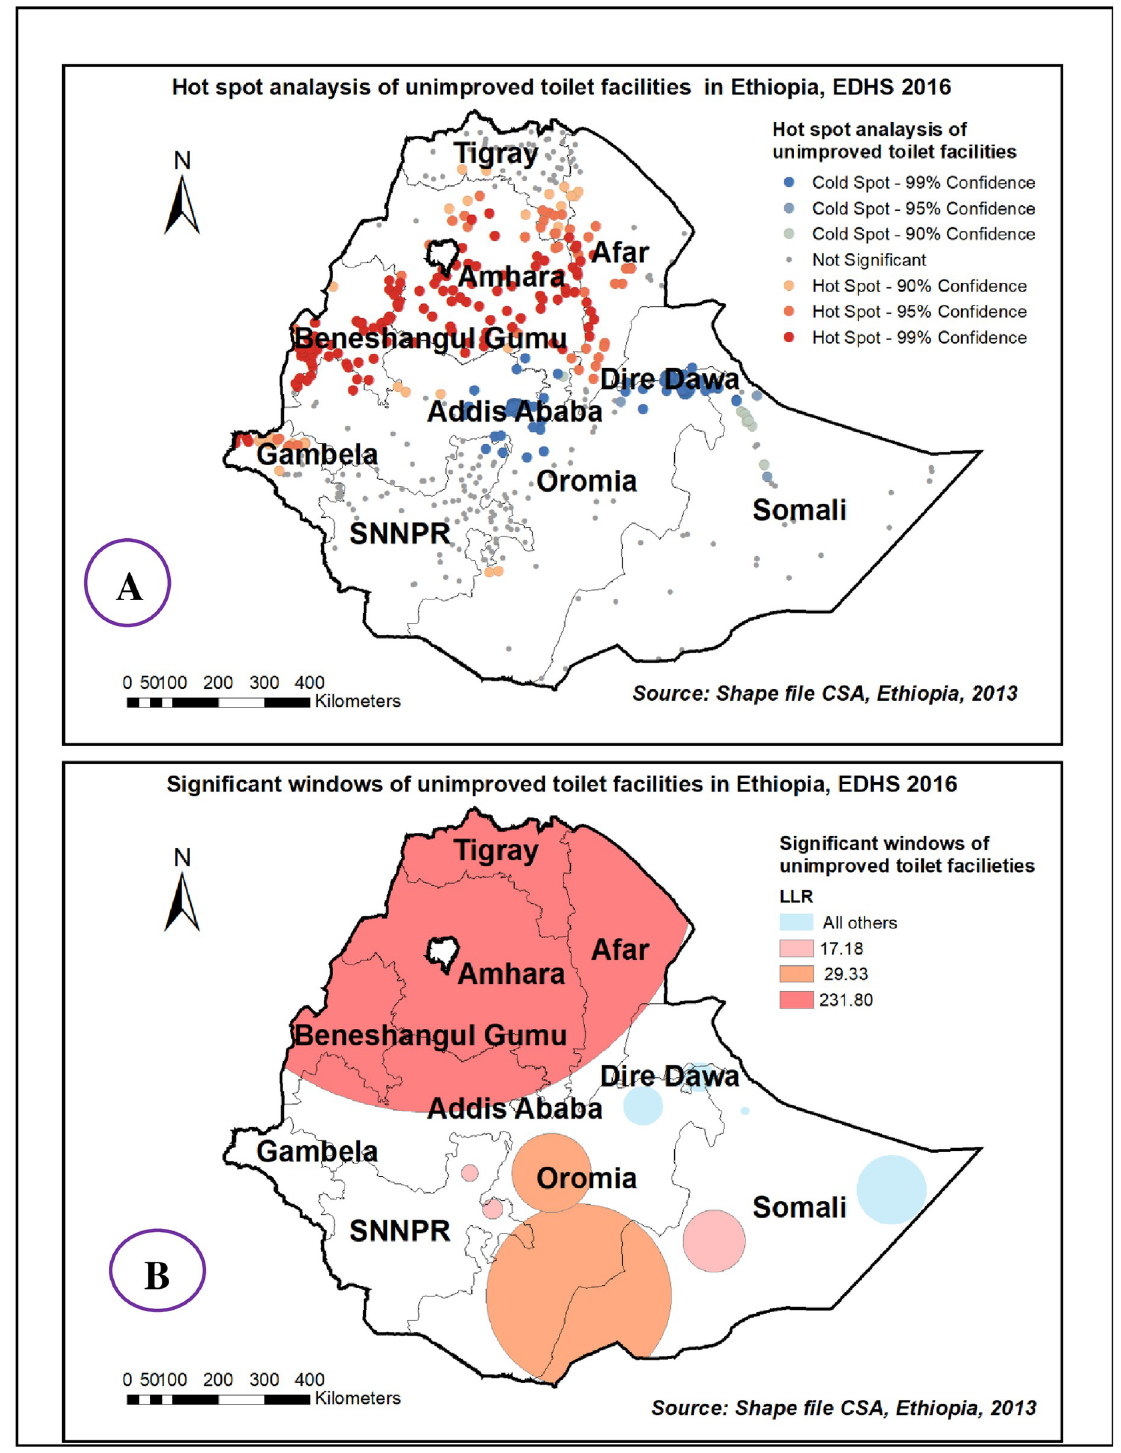
Fig 8. Hot spot areas (A) and significant windows (B) of unimproved toilet facilities in Ethiopia, EDHS 2016, shapefile from 2018 GADM and plotted using ArcMap version 10.7 software.